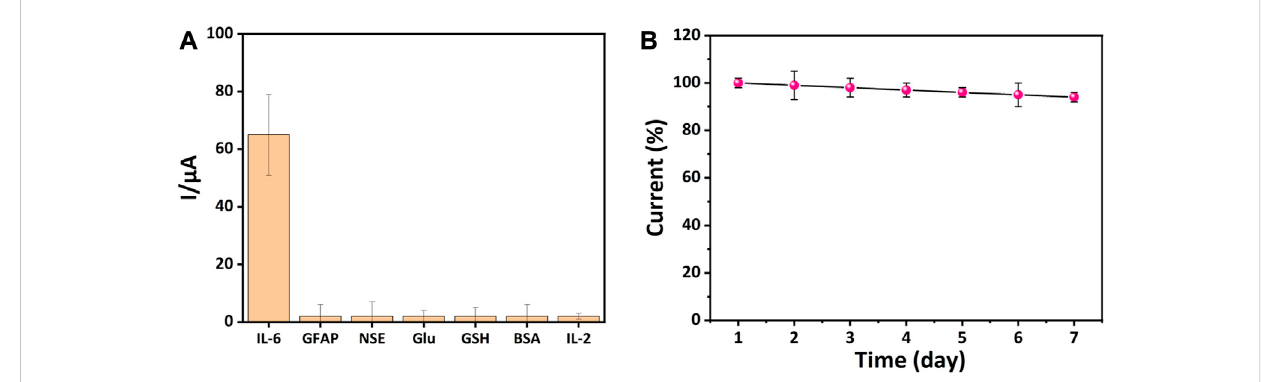
FIGURE 6 Detection of speci fi city and stability of electrochemical immunosensors. (A) The speci fi city of the constructed immunosensor towards GFAP, NSE, Glu, GSH, BSA, and IL-2 (The concentration of IL-6 was 10 pg/mL, and theinterferents were1 ng/mL). (B) The stability of theconstructed immunosensor (n =